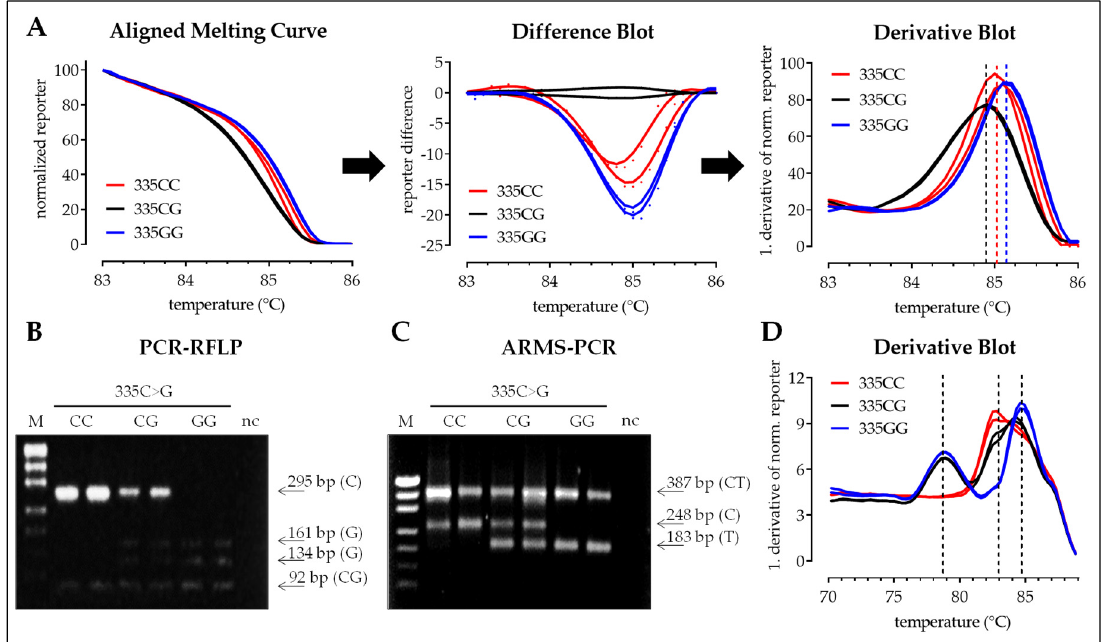
Figure 8. Detection of SNP 335C>G with four different methods: HRM-PCR, PCR-RFLP, conventional, and one-step ARMS-PCR. ( A ) High resolution melting curve analysis following SNP flanking PCR can be done using the aligned melting curve (normalized reporter), the resulting difference blot (difference of the normalized reporter with heterozygous samples as reference), or derivative blot (1. derivative of the normalized reporter). ( B ) Representative band pattern following enzymatic digestion of the SNP flanking PCR products with HpaII (PCR-RFLP). ( C ) Representative band pattern of the conventional ARMS-PCR. ( D ) Melting curve analysis following one-step ARMS-PCR is performed with the derivative blot (1. derivative of the reporter). Presented data